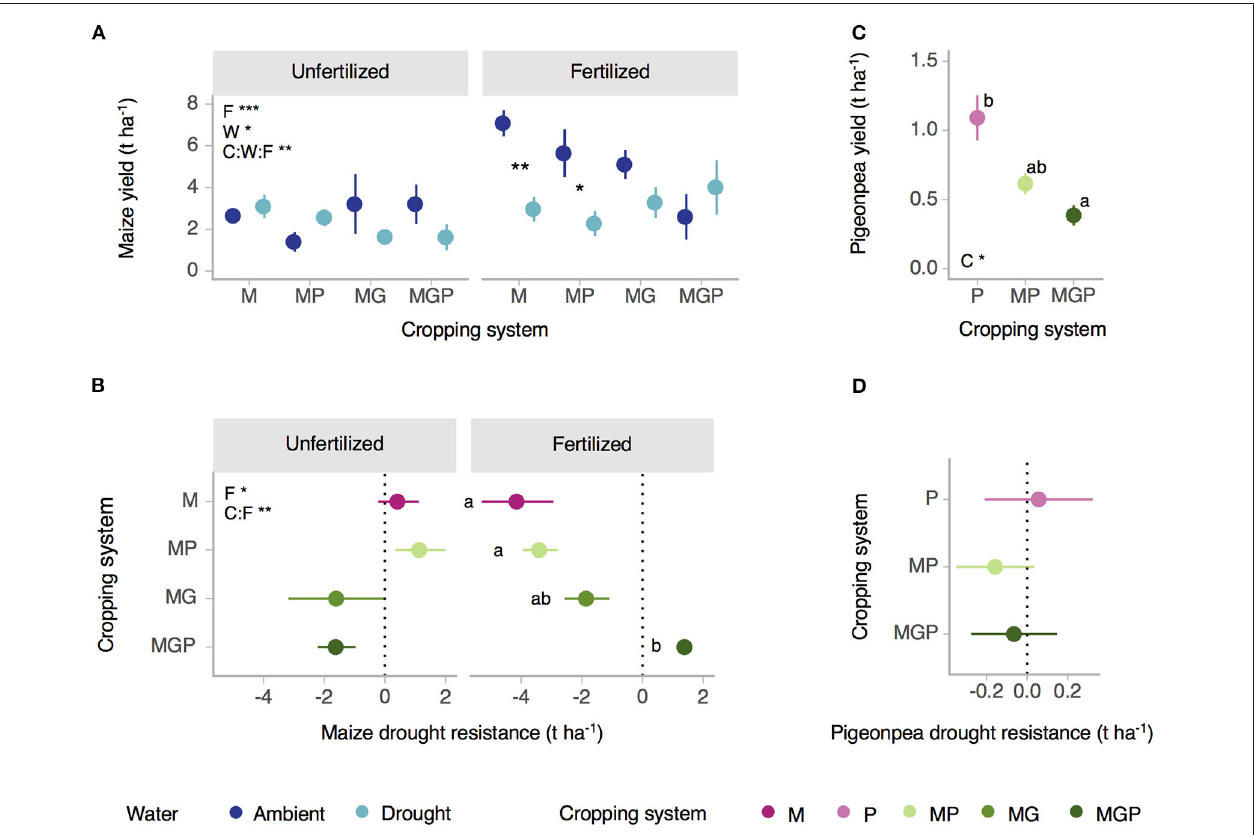
FIGURE 3 | Effects of water, cropping system, and fertilization on (A) maize grain yield at 12% moisture and (C) pigeonpea dry grain yield. Effects of cropping system and fertilization on yield drought resistance of (B) maize and (D) pigeonpea. Dotted lines indicate high drought resistance (zero change due to drought). Cropping system abbreviations: M, Maize; P, Pigeonpea; MP, Maize-pigeonpea; MG, Maize-gliricidia; MGP, Maize-gliricidia-pigeonpea. Treatment factor abbreviations: W, Water; C, Cropping system; F, Fertilization. Asterisks indicate significance of treatment effects or significant differences between ambient and drought (*** p <